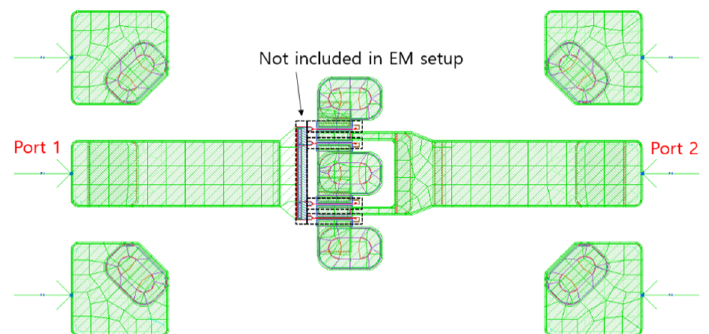
Figure 7. Top view of full EM simulation of a GaN HEMT using ADS momentum. C ds1 , C ds2 , and L ds composing the “modified C ds ” are extracted through fitting or opti-